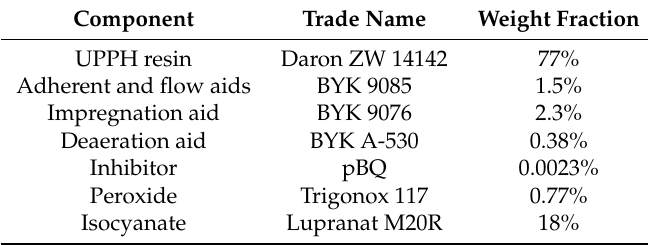
Table 1. Composition of the unsaturated polyester polyurethane hybrid (UPPH) resin [18]. Component Trade Name Weight